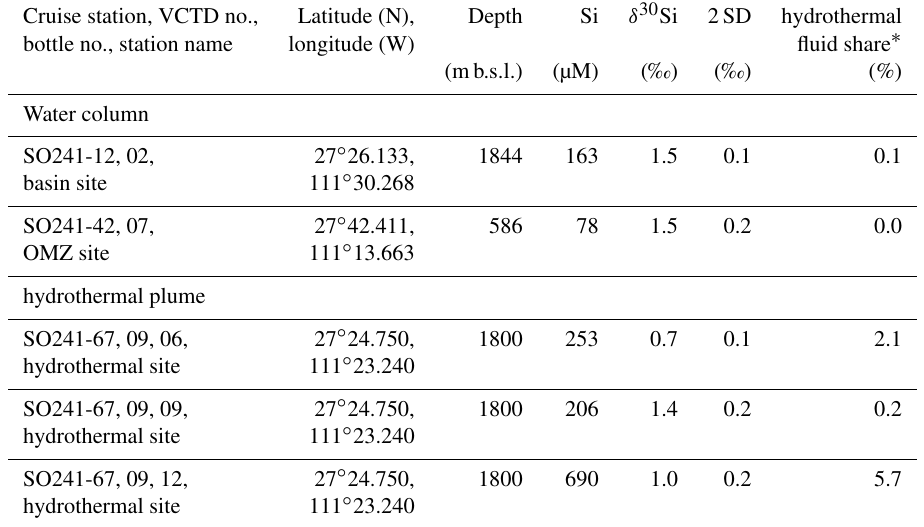
Table 2. Water column and hydrothermal plume Si concentration (µM) and Si isotope values (‰). Additionally, the share of hydrothermal fluids within the hydrothermal plume is given based on the calculation provided by Berndt et al. (2016) in their Supplement. Cruise station, VCTD no.,